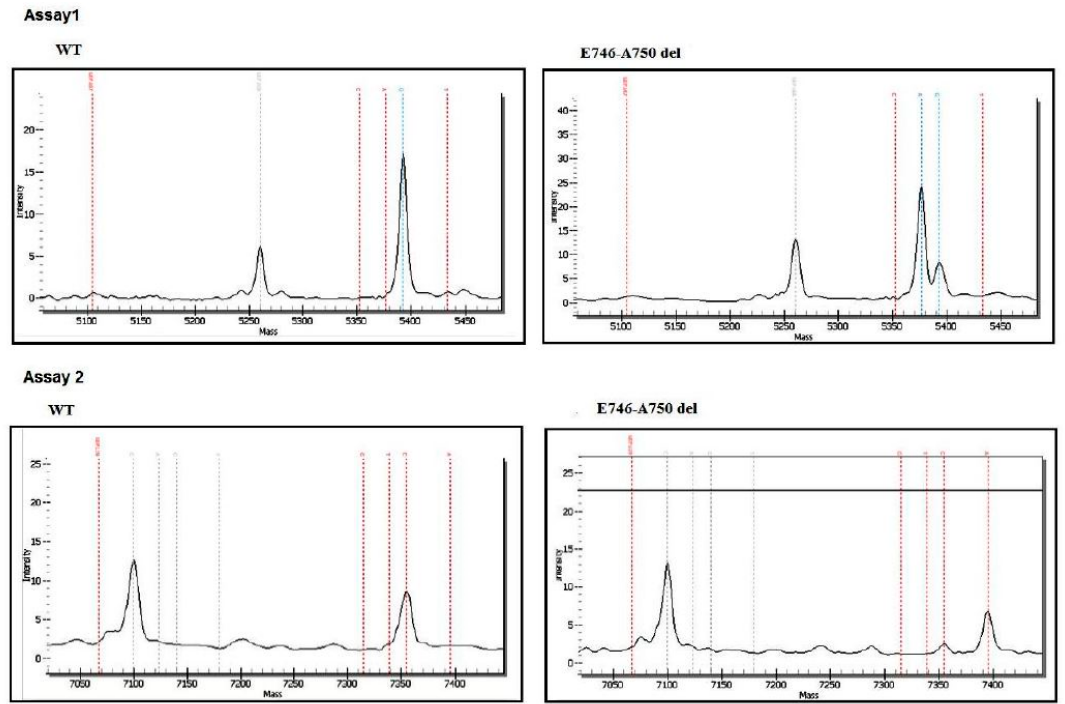
Figure 3. Spectrum of the Sequenom assay shows EGFR E746-A750 del (exon 19).